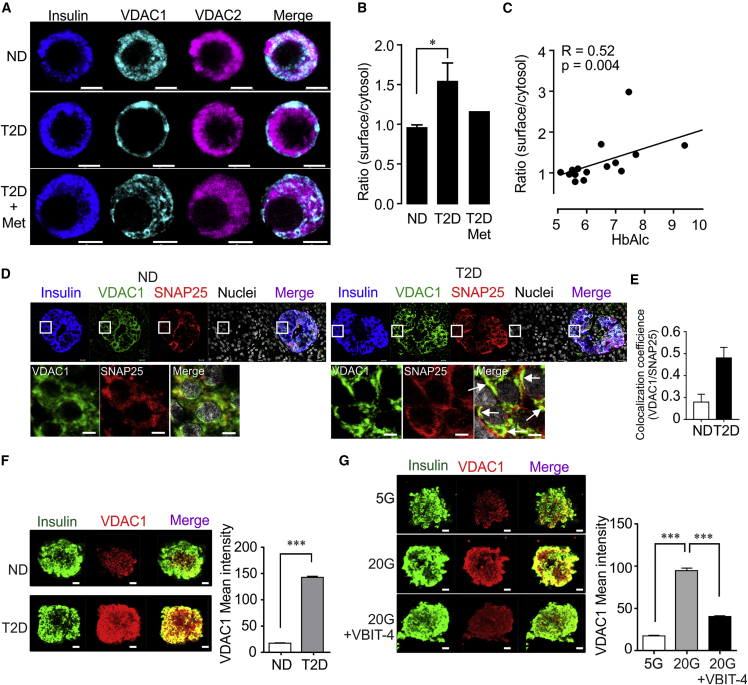
VDAC1 Localization in β Cells from ND and T2D Islet Donors(A) Representative immunofluorescence images of VDAC1 and VDAC2 in human islet β cells from non-diabetic (ND) and T2D donors, one of whom had received metformin therapy. Note VDAC1 expressed prominently on the β cell surface in T2D islets.(B) β cell surface expression of VDAC1 given as ratio of surface/cytosolic VDAC1 immunofluorescence intensity in β cells of ND or T2D (12–15 cells/donor were acquired for the analysis, 8 donors each in the ND and T2D group) and the one with metformin therapy (12 cells).(C) Correlation between VDAC1 β cell surface expression and HbA1c values in 15 islet donors (ND and T2D).(D) Confocal image of VDAC1 co-localization with SNAP-25 by double immunostaining in insulin-positive cells in pancreatic sections from ND and T2D donors (3 donors with 27 islets in each group). Scale bar indicates 5 μm. Arrows show co-localization of VDAC1 and SNAP-25 also magnified in the squares. Mean SNAP-25 intensity/islet was 10.2 ± 2.4 for ND and 10.5 ± 3.9 for T2D, respectively.(E) Calculation of coefficients (VDAC1/SNAP-25) was performed using a confocal image analyzer (ZEN2012).(F) Representative immunofluorescence images of VDAC1 expression in isolated islets from two ND and one T2D donor. Mean ± SEM of 12–20 islets from each condition were analyzed.(G) Representative immunofluorescence images of VDAC1 expression and its co-staining with insulin-positive cells in islets from two ND donors cultured at 5 or 20 mM glucose ± VBIT-4 (20 μM) for 72 hr. Scale bar indicates 10 μm.